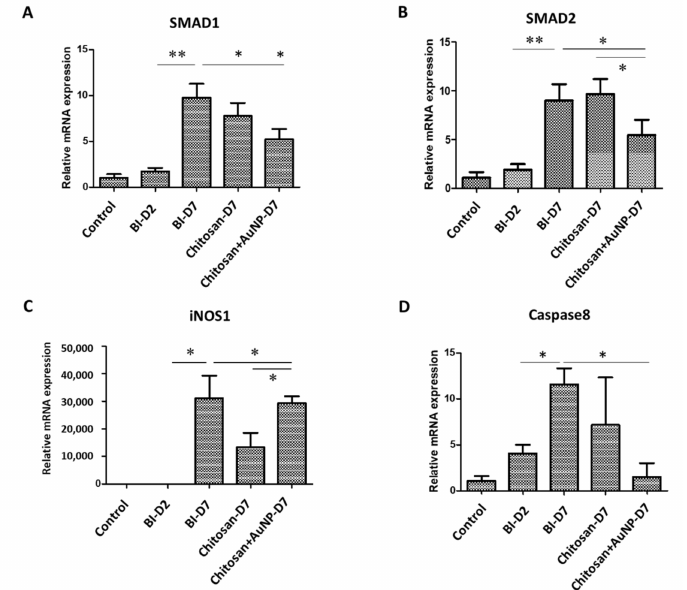
Figure 6. The relative mRNA expression level of several fibrotic biomarkers in rat burn wound tissues from the control, lesion, chitosan dressing, and AuNP-coated chitosan dressing groups. ( A ) SMAD1; ( B ) SMAD2; ( C ) iNOS1; ( D ) Caspase-8. Control = normal control group; BI D2 = lesion control group day 2 post-wounding; BI D7 = lesion control group day 7 post-wounding; Chi D7 = chitosan dressing treatment day 7 post-wounding; Chi + AuNP30 D7 = AuNP-coated chitosan dressing treatment day 7 post-wounding; * p < 0.05, ** p <